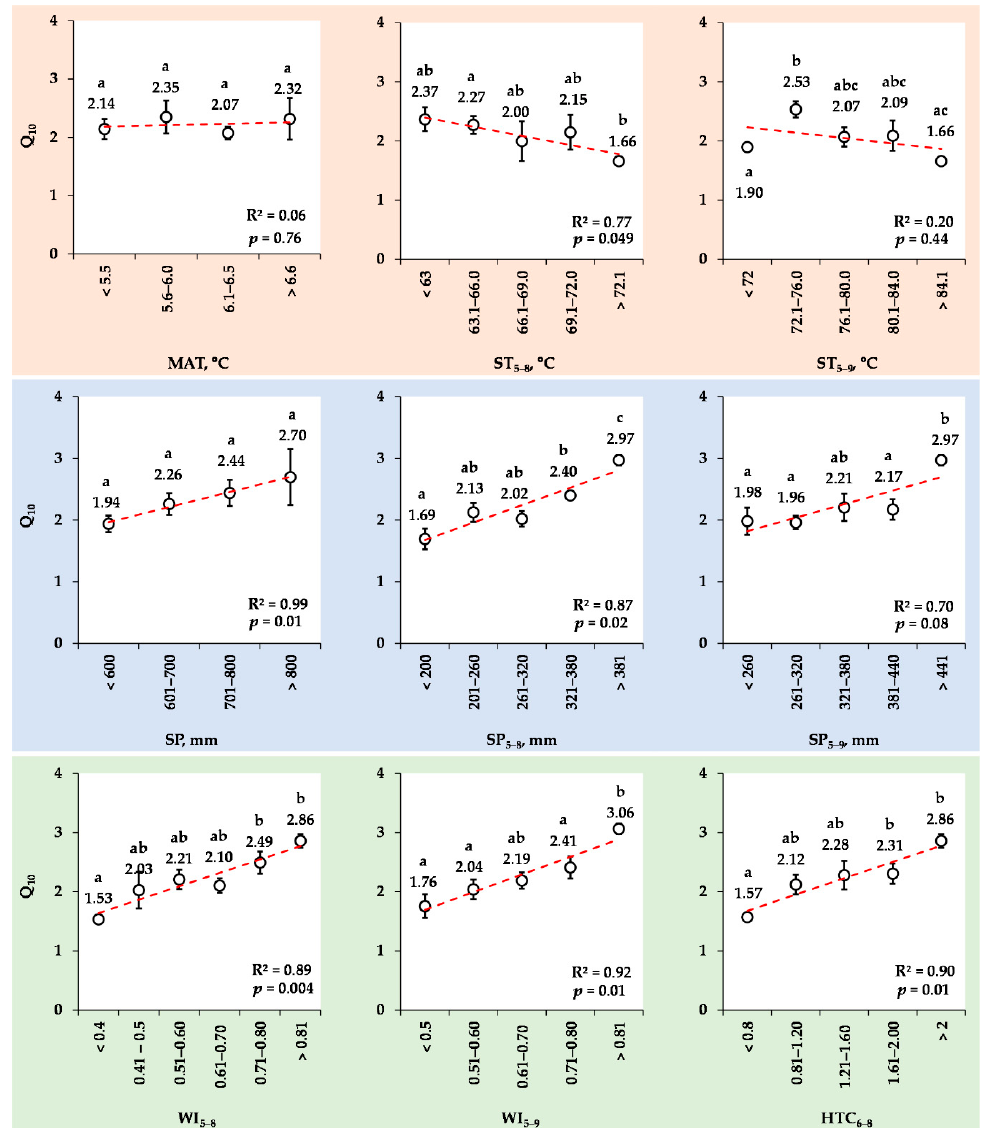
Figure 8. Rank correlations between the mean Q 10 values in the sandy Entic Podzol and meteorological indexes: MAT, °C mean annual Tair; ST 5–8 and ST 5–9 (°C) are the sums of the mean monthly Tair from May to August and May to September, respectively; SP is the annual sum of precipitation (mm); SP 5 − 8 and SP 5–9 are the sums of the monthly precipitation from May to August and May to September, respectively; WI 5–8 and WI 5 − 9 are the wetness indexes from May to August and May to September, respectively; HTC 6–8 is the hydrothermal coefficient over the summer period (June–August). Letters indicate significant differences at p < 0.05.